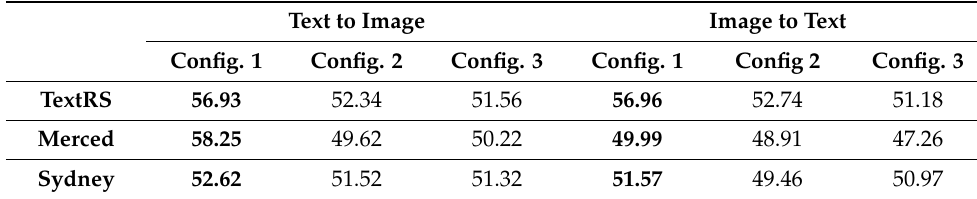
Table 4. Average mR retrieval results for TextRS, Merced, and Sydney datasets based on three dif- ferent configurations: Config. 1: models pre-trained on text–image matching; Config. 2: models pre- trained in a self-supervised mode; Config. 3: models pre-trained in a supervised mode .